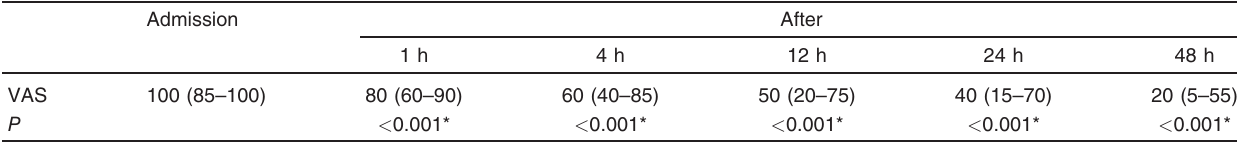
Table 12 Improvement of visual analog score in successful cases of group II ( n = 19) at different studied